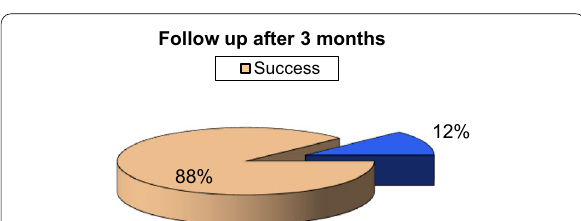
Fig. 7 The percentage of procedures follow‑up result after 3 months done in our